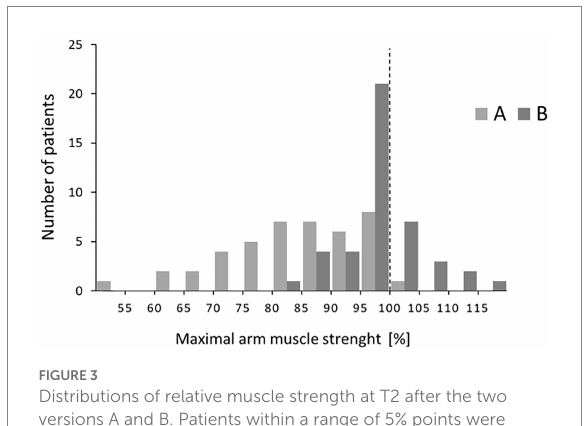
FIGURE 3 Distributions of relative muscle strength at T2 after the two versions A and B. Patients within a range of 5% points were grouped (e.g., 80%–84%).